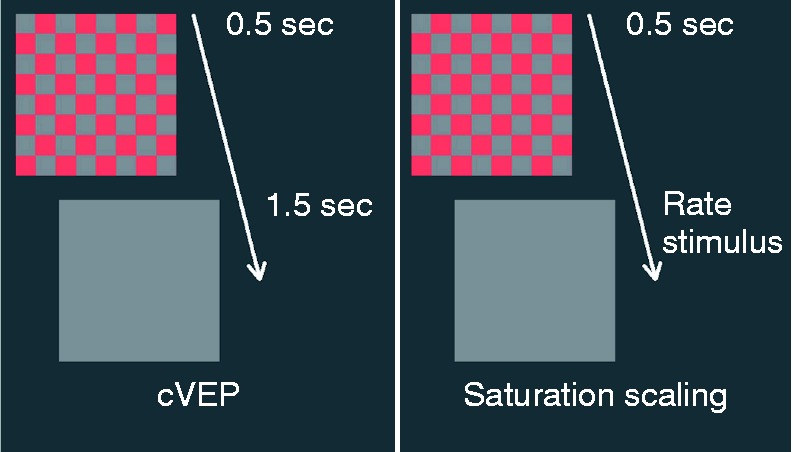
Representation of the appearance–disappearance stimulus with time during the cVEP
and scaling experiments. For 0.5 s, a checkerboard of squares was visible. In the
checkerboard, squares of equiluminant red of a specific cone contrast alternated
with squares that were gray like the background. This “on” pattern consisted of
32 × 32 squares covering 10° × 10° of arc subtended at the eye and was followed by
an interval during which the entire screen was uniform gray (“off”). The transition
between “on” and “off” patterns occurred suddenly; thus, the temporal modulation
signal was a rectangular wave. All checks and the background were the same
luminance. During cVEP experiments, the “off” pattern of duration was 1.5 s, with
the “on/off” cycle being repeated 30 times per stimulus. During scaling experiments,
the “off” pattern lasted until the participant had completed the saturation ratings
for the stimulus, after which the next stimulus was presented.